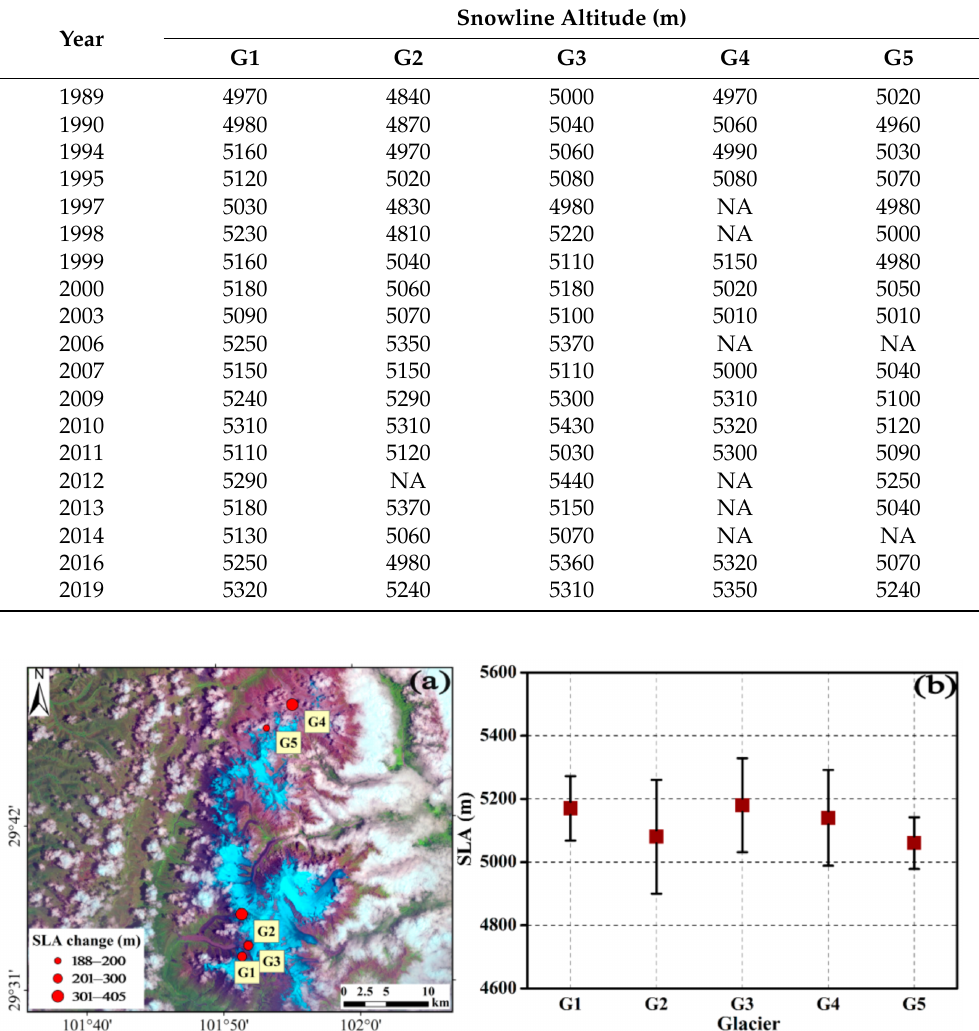
Figure 12. ( a ) SLA changes and ( b ) mean SLA of the five analyzed glaciers across the Gongga Mountains during the 1989–2019 period. Error bars in ( b ) represent one standard deviation from the